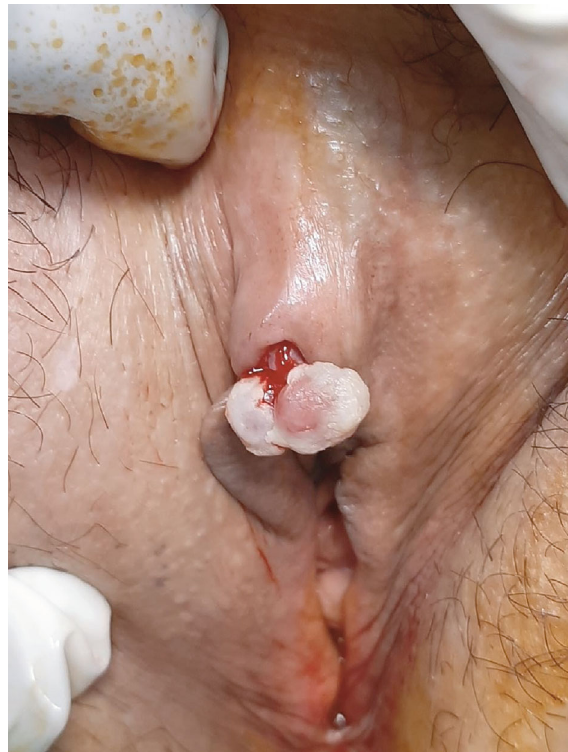
Figure 1: A 2 : 5 × 0 : 5 cm pedunculated and easy bleeding lesion beneath the clitoral hood.